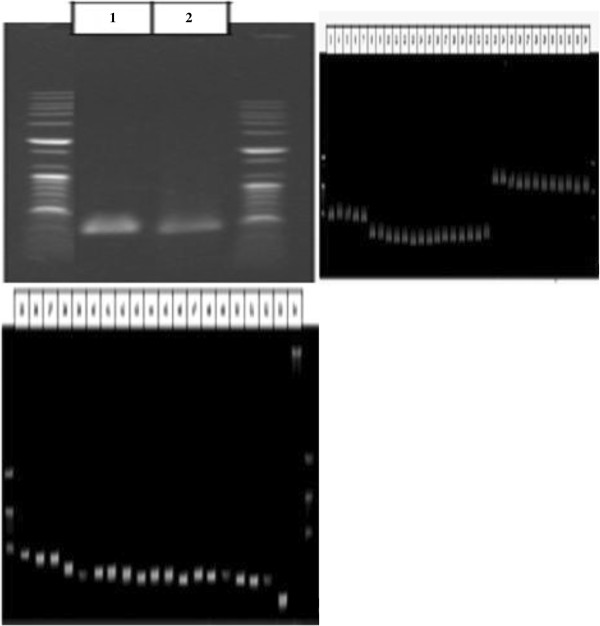
The
Polymerase Chain Reaction
(
PCR
) on
DNA isolated
with standard
protocol
; PCR amplification of DNA from bacterial strains by (NO.1-7) H.bilis P17f/P17r primer; (NO. 8-22)
H.canis
canis3F/canis4r primer; (NO.23-34)
H.salomonis
HSALF/HSALR primer; (NO.35-37) H.felis Fe1f/Fe3r primer; (NO.38-52)
H.bizzozeronii
Bi1F/Bi2R primer; (NO.53)
H.pylori
HP-for/HP-REV Primer, and 100-bp molecular ladder.